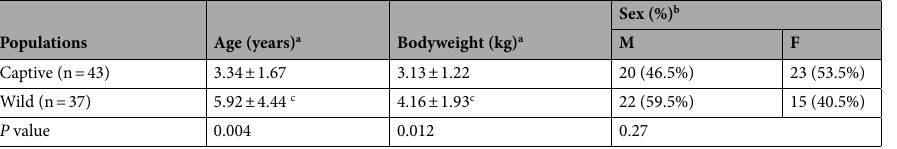
Table 1. Characteristics of captive and wild macaque populations in this study. a Values shown as mean ± SD with P value from statistical t -test. b Percentage (%) of sex proportion per group tested by Fisher’s exact test. c The absent data of six wild macaques were excluded.